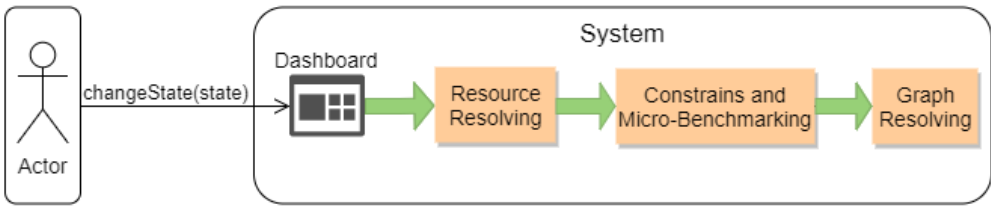
Figure 13. System Life cycle on State